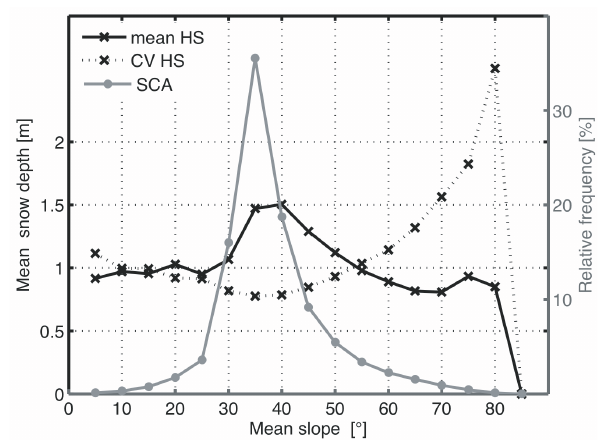
Fig. 8. Left axis: Histogram (calculated for classes with a step width of 5 ◦ slope) of the mean snow depth (mean HS, left axis) and its coefficient of variation (CV HS). Right axis: Relative frequency of the snow covered cells (SCA) in the rock face Ch¨upfenflue on 27 March 2009.